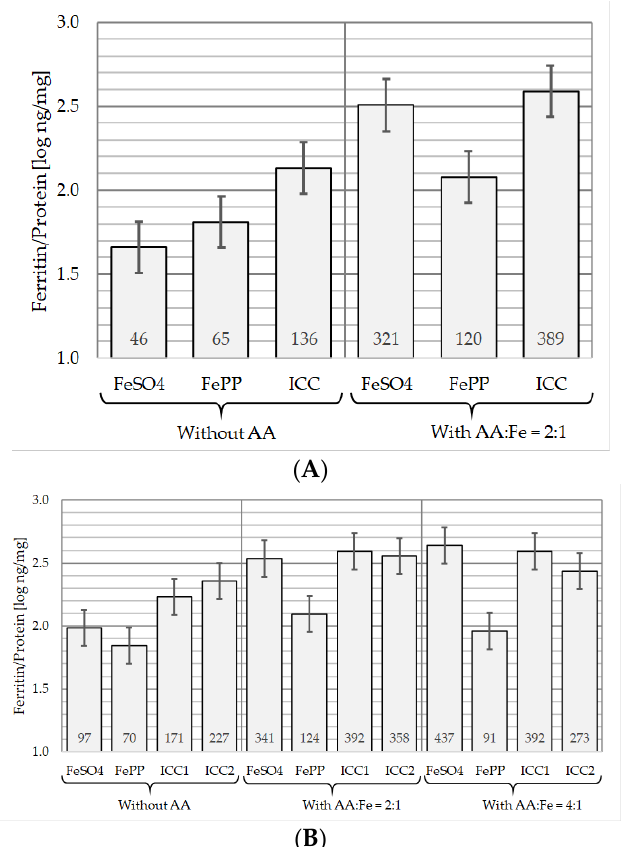
Figure 3. Iron uptake from ferrous sulfate (FeSO 4 ), micronized ferric pyrophosphate (FePP), and iron‒casein complexes (ICCs) by Caco-2 cells after simulated in vitro digestion in water ( A ) and milk ( B ) with and without ascorbic acid (AA) ( n = 3). In water, only ICC1 (2.8%) was tested. The two batches of ICC (i.e., 2.8% and 2.9%) were evaluated in milk. The iron was added to both drinks at a level of 3.3 mg Fe/250 mL. Molar ratios of AA to iron (Fe) are provided on the figure. The data presented are measurements of ng ferritin/mg protein after log transformation (de-log means are given on the bars). One-way analysis of variance and pairwise comparisons were performed using the Tukey‒Kramer method. Means ± 0.5 × HSD5% are presented, so that two conditions are significantly different if their error bars do not overlap.